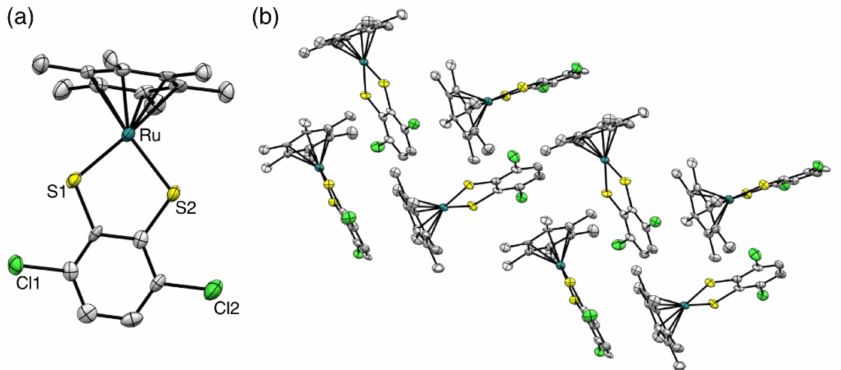
Figure 1. ( a ) ORTEP drawing of 1c with thermal ellipsoids at the 50% probability level. Hydrogen atoms are omitted for clarity. Color codes: light grey, C; yellow, S; green, Cl; turquoise blue, Ru. ( b ) Packing structure of 1c .